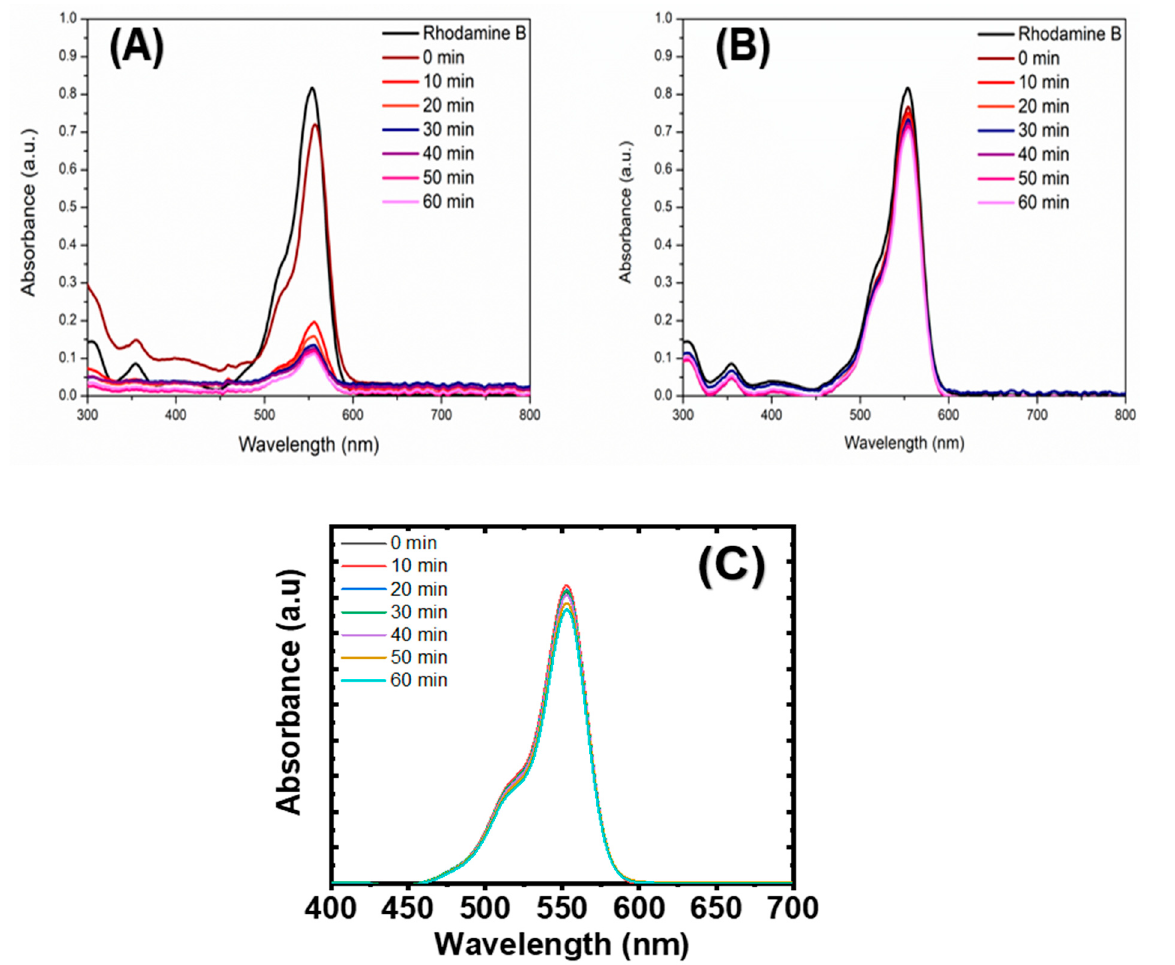
Figure 11. The absorption spectra of the rhodamine B solution using CuFe 2 O 4 at: ( A ) 400 °C, ( B ) 1100 °C, and ( C ) photolysis.